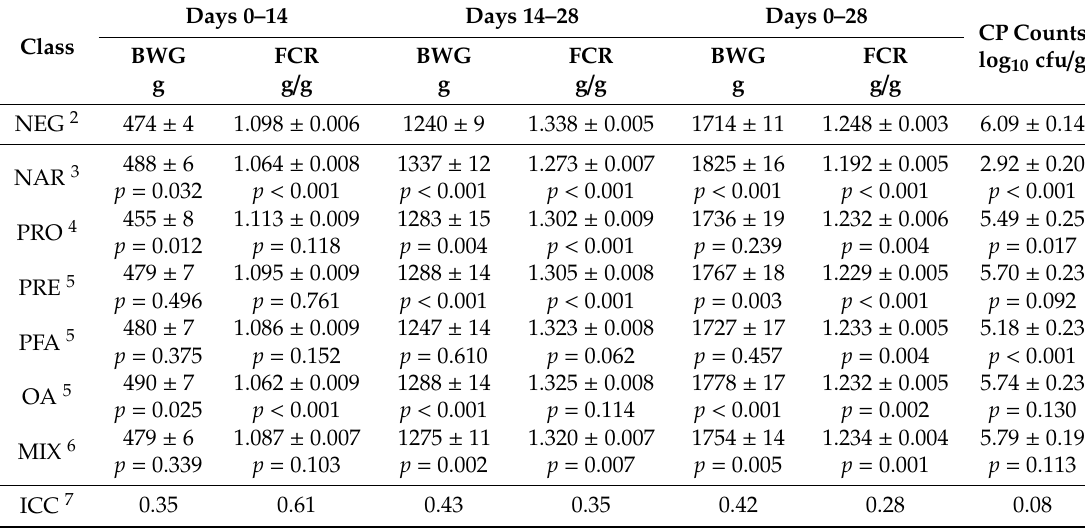
Table 4. Body weight gain, feed conversion ratio and Clostridium perfringens counts for negative control, narasin and classes of alternatives to antibiotics 1